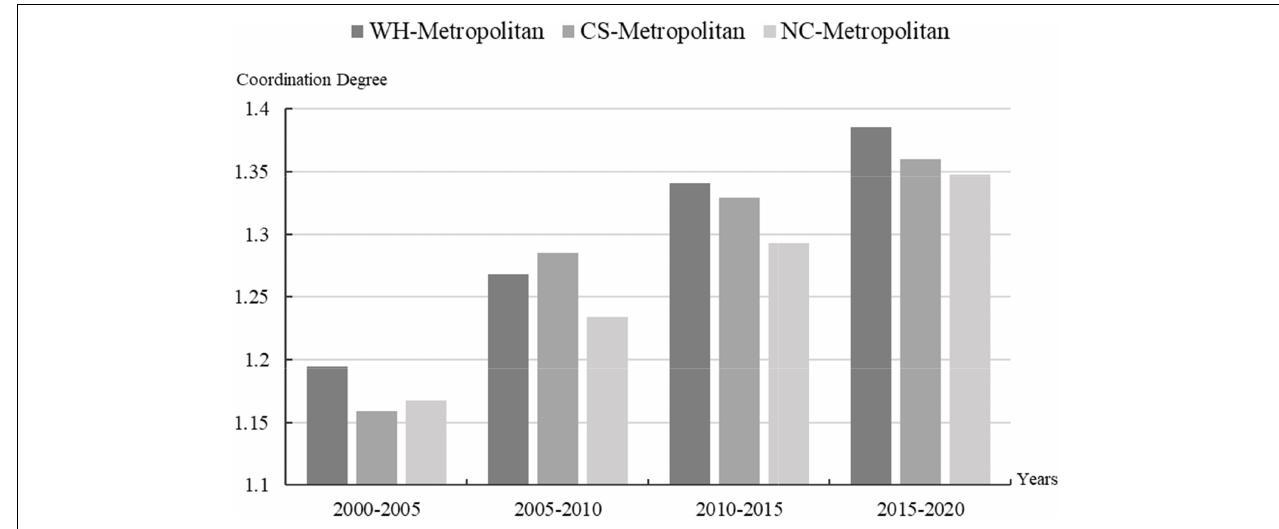
FIGURE 5 | Change in the coordination degree of “construction land–population” in the three metropolitan regions from 2000 to 2020.